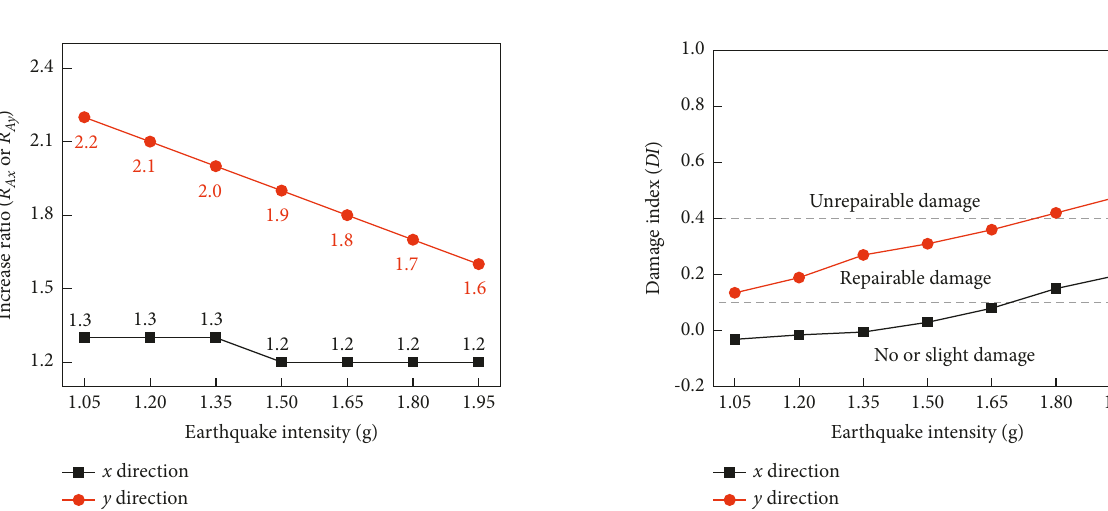
Figure 15: Comparison of maximum absolute displacement (in x and y directions) at the top of specimen.